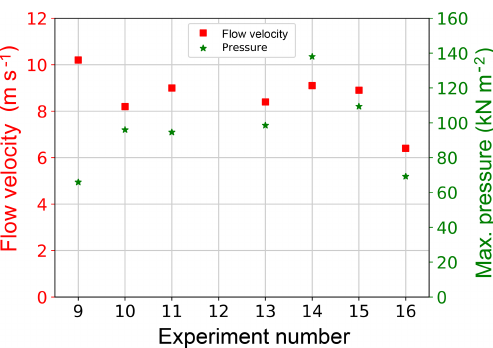
Figure 7. Relation between the fine content (silt and clay) of the granular material of selected experimental tests and the observed maximum flow height.